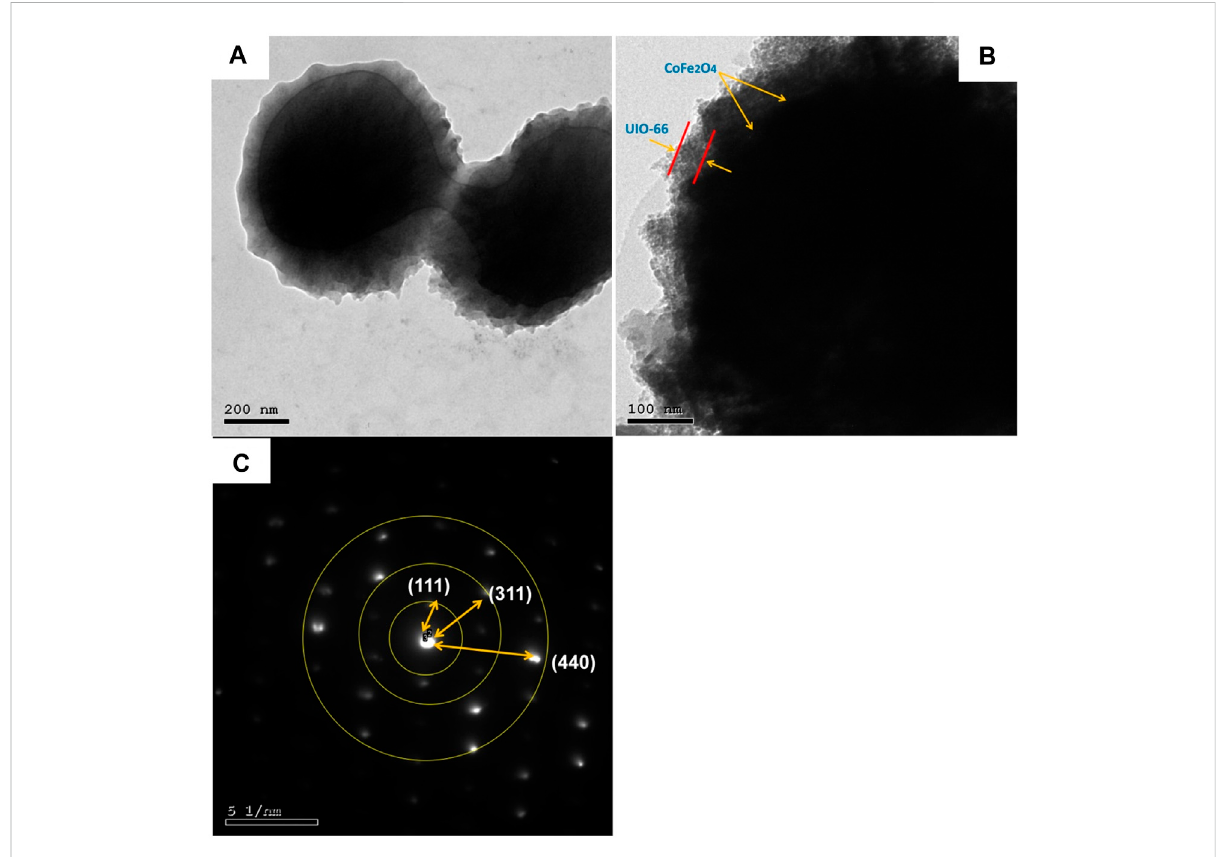
FIGURE 4 TEM images (A,B) and SAED pattern (C) of CoFe 2 O 4 @UiO-66